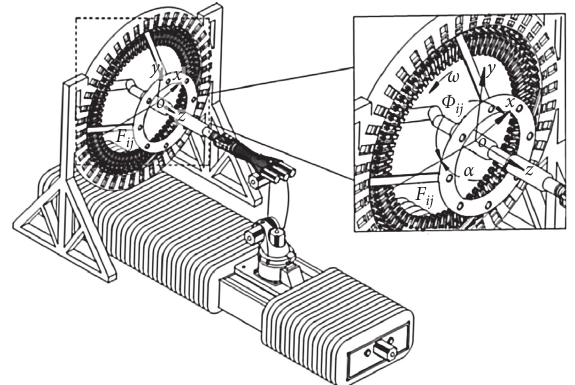
Figure 1: Diagram of the mandrel dragged by the robot in a three-dimensional braiding machine.